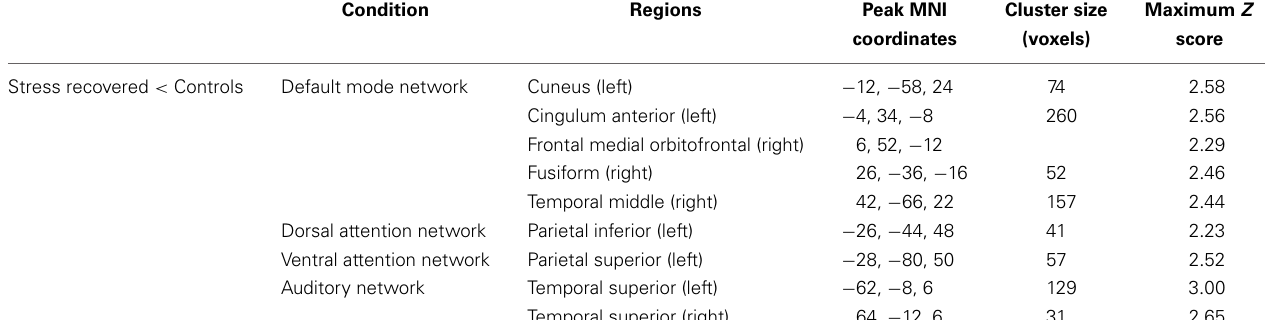
Table 4 | Group differences (Stress recovered < Controls) in brain regions of the DMN, DAN, VAN, and AN maps in task-induced deactivation (two sample t -tests, corrected for multiple comparisons, p < 0 . 05).